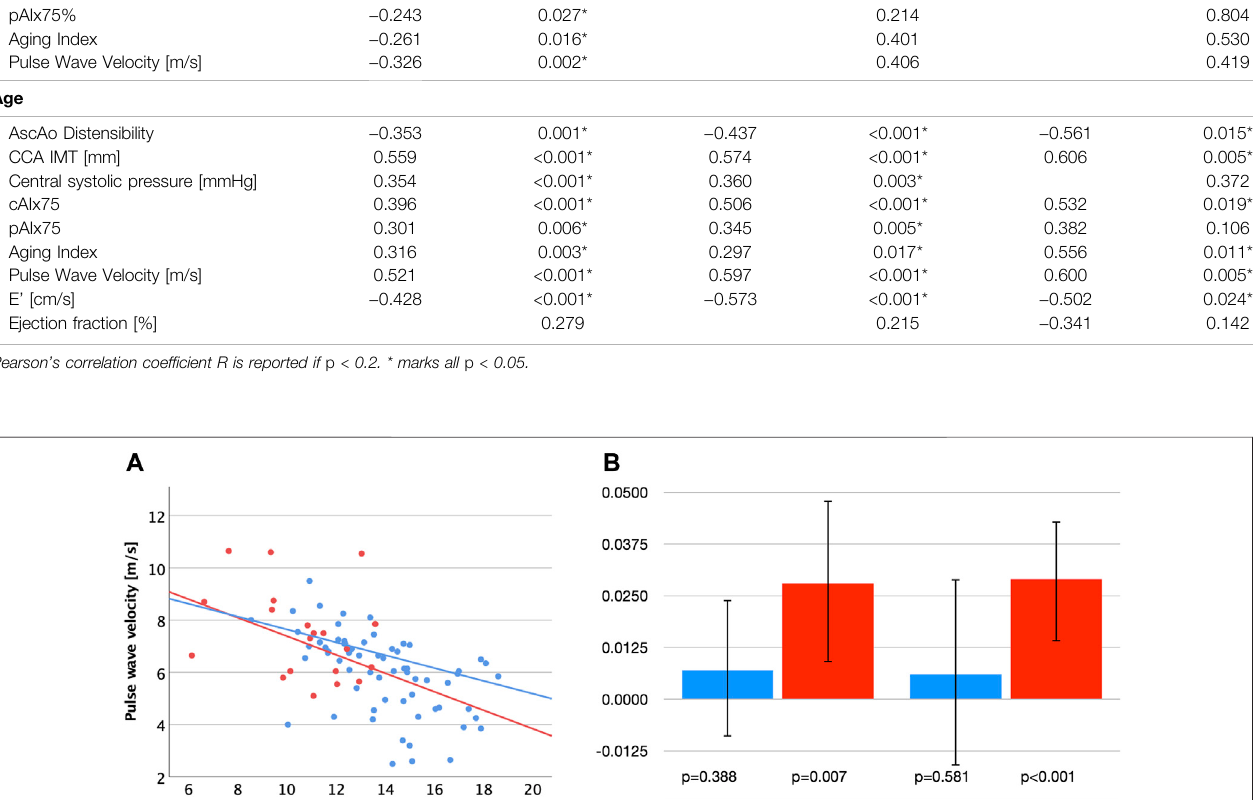
Frontiers in Physiology |